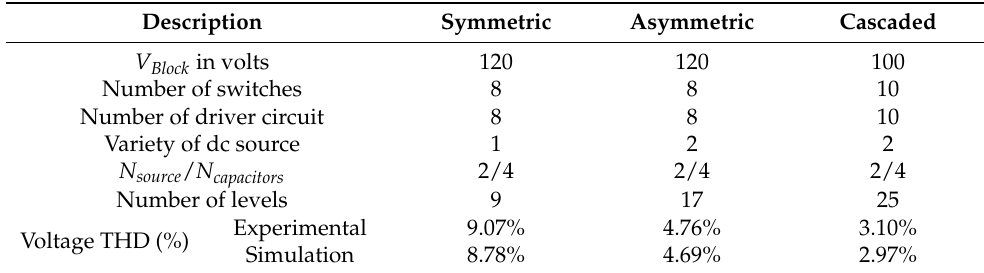
Table 5. Comparison of the proposed symmetric, asymmetric, and cascaded Configuration.